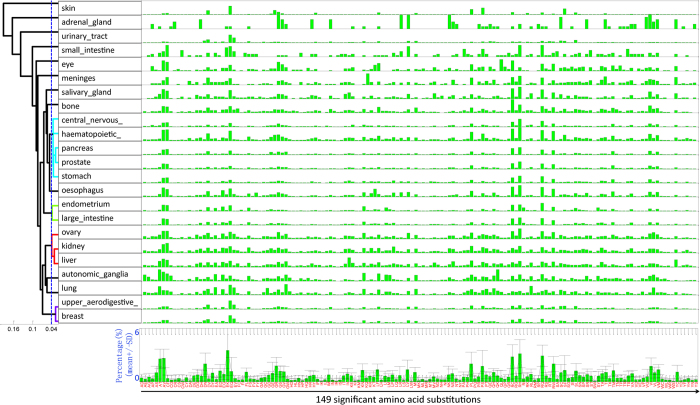
Distribution of mutation frequency along 149 significant amino acid substitutions.Each row of the upper panel corresponds to one cancer as denoted on the left, and each bar stands for the occurrence frequency of a residue substitution as represented in the bottom subfigure. All 149 frequencies of each cancer constitute its substitution spectrum; then cancers are clustered according to their similarity in substitution spectra, as shown by the left dendrogram. The lower panel shows the average substitution spectrum for all the cancers with standard deviations denoted. A higher resolution of the average substitution spectrum and the clustering dendrogram is included in supplementary Figure S26.